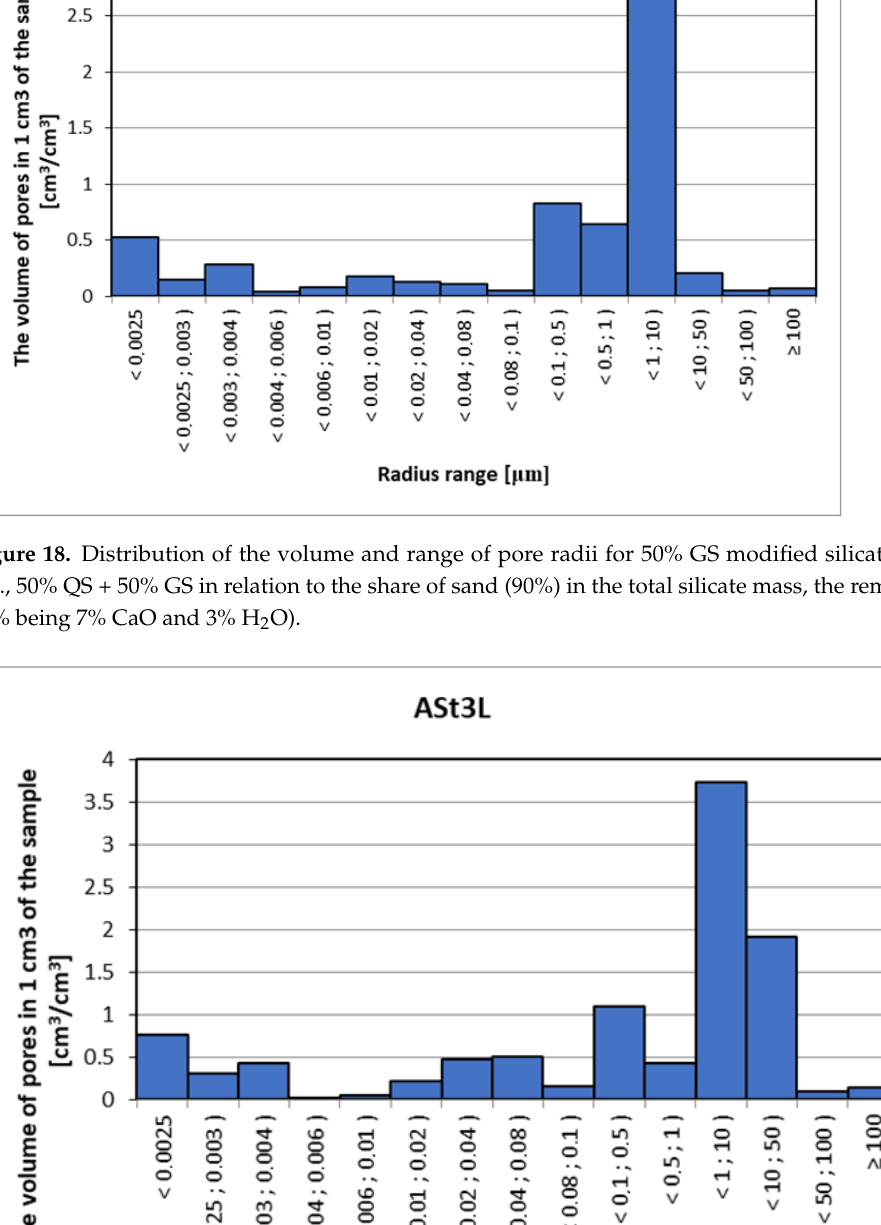
Figure 19. Distribution of the volume and the range of pore radii for silicate brick modified with 90% glass sand (GS).